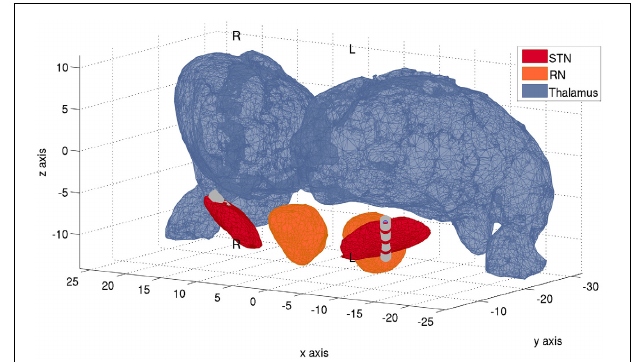
FIGURE 2 | Localization of electrodes within the STN. Anatomical localizations of the quadripolar Medtronic DBS leads bilaterally, with 4 electrode contacts each. Electrode contacts are denoted by the gray cilinders. Reconstruction of electrode trajectory was performed as in Horn et al. (2013) and after normalization of pre-surgical MR-images into standard space. More ventral electrode contacts (0) lie toward the negative z-axis, whereas more dorsal contact electrodes (3) lie toward the direction of positive z-axis. In the left STN, contacts 1 and 2 lie within the STN, contact 0 intersects significantly with it and the most dorsal contact 3 only intersects minimally with it. In the right STN, contacts 0-1-2 lie within the boundaries of the STN, whereas the most dorsal contact 3 intersects minimally with it. Plot performed with MATLAB ® function